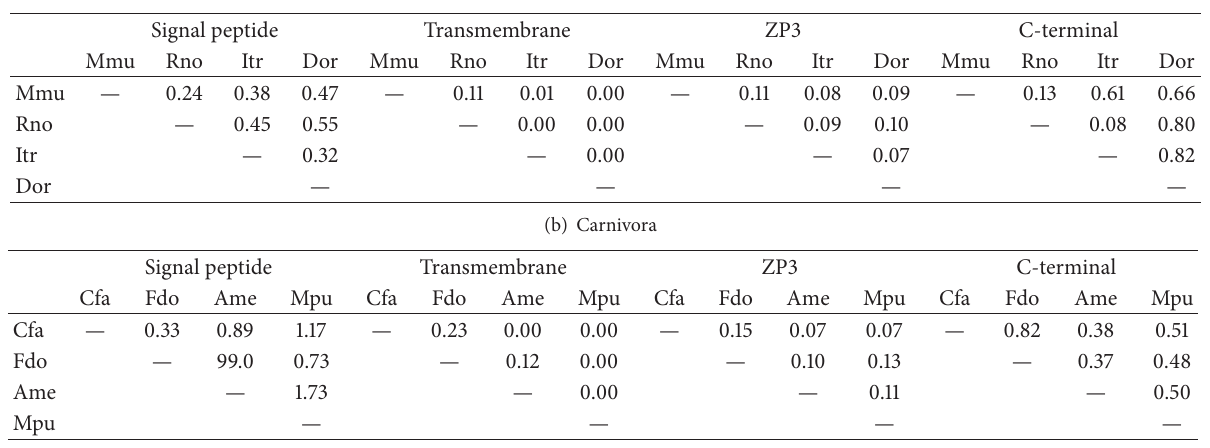
Table 1: Nonsynonymous (dN) and synonymous (dS) substitution ratios (dN/dS) for each of the four PLAC1 protein domains among four rodent and four carnivore species used in this study. A dN/dS < 1.00 is an indication of purifying selection. Species abbreviations are given in the